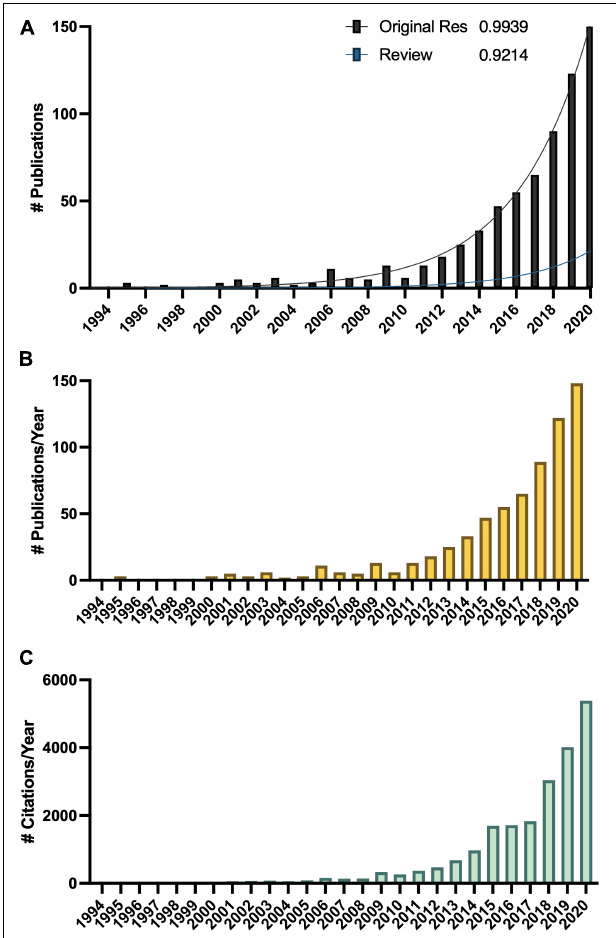
FIGURE 3 | Growth in the melatonin literature (A) total number of publications, with R 2 indicating best fit to an exponential curve, (B) total number published per year, and (C) total number of citations of articles captured in this analysis per year according to Web of